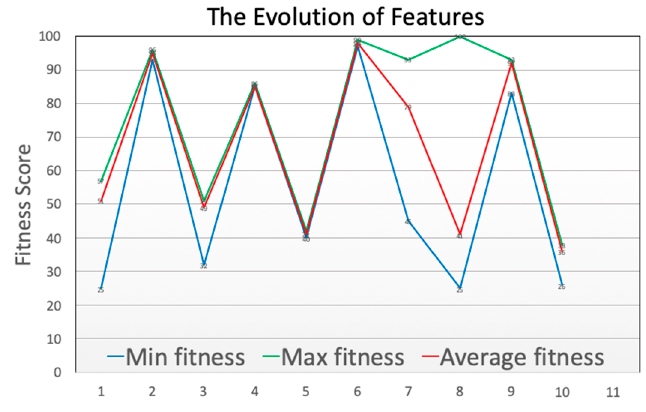
Figure 13. The evolution of features during the evolutionary learning in terms of fitness score.